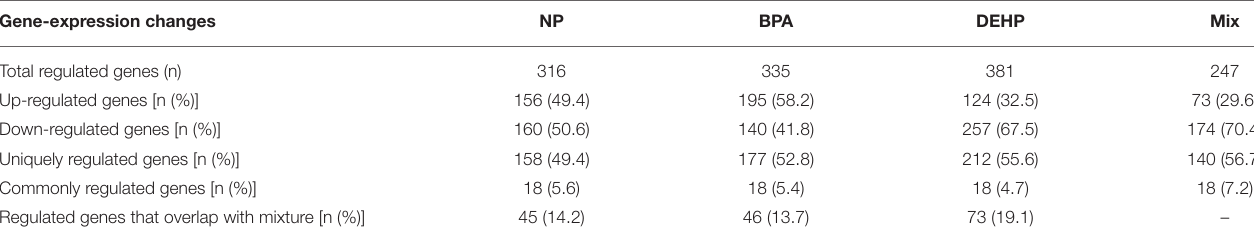
TABLE 2 | Gene expression changes in the liver of male fathead minnow response to exposure to NP, BPA, DEHP and the mixture. Gene-expression